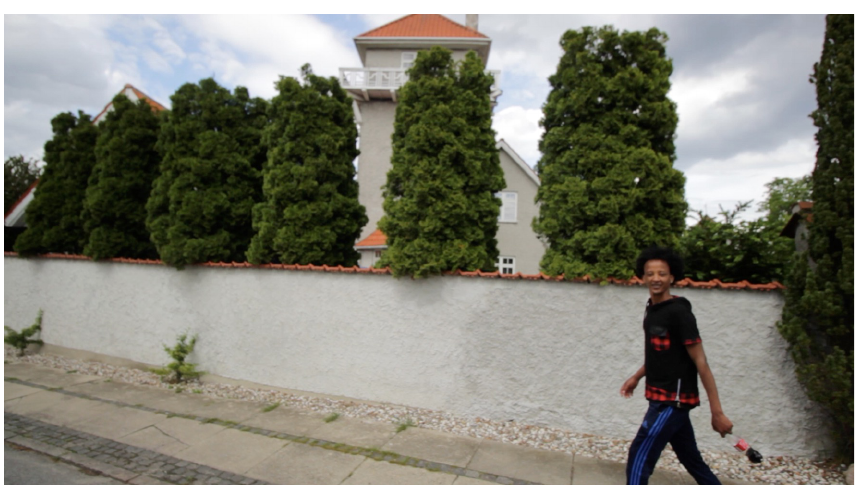
Figure 2. Passing a neighbouring house. May